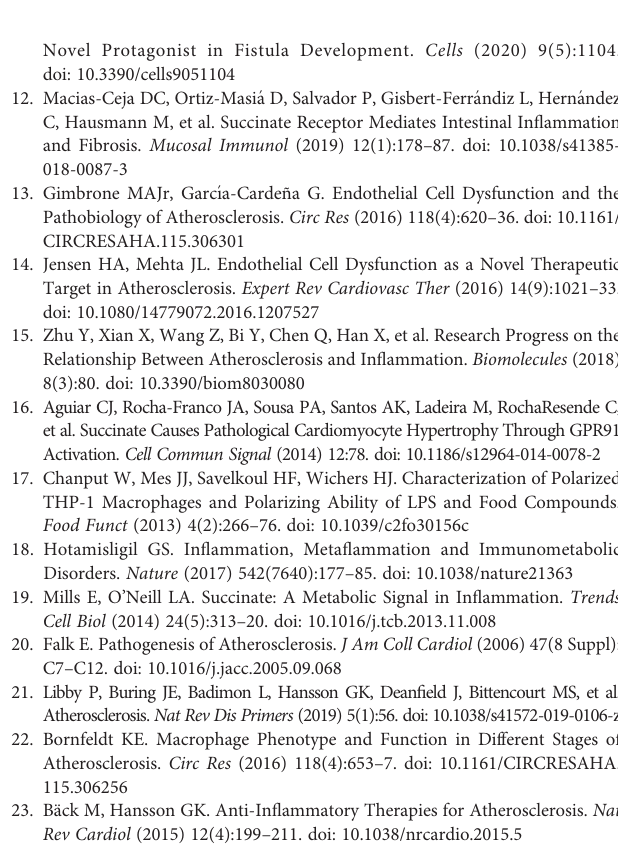
Supplementary Table 1 | Clinical parameter statistics. Supplementary Figure 1 | Cell viability assay for drug intervention via CCK8. Supplementary Figure 2 | Transfection ef fi ciency of Hif-1 a siRNA via rt-PCR. Supplementary Figure 3 | Expression of representative M1 marker genes of THP-1 macrophage after 24 h of LPS polarization. Supplementary Figure 4 | Raw data review incoming and outgoing emails. Supplementary Figure 5 | Repeated experiment of caspase-1 in a blot. Supplementary Figure 6 | Sucnr1 blots between DMSO and blank control. Supplementary Figure 7 | En face staining of Aortic